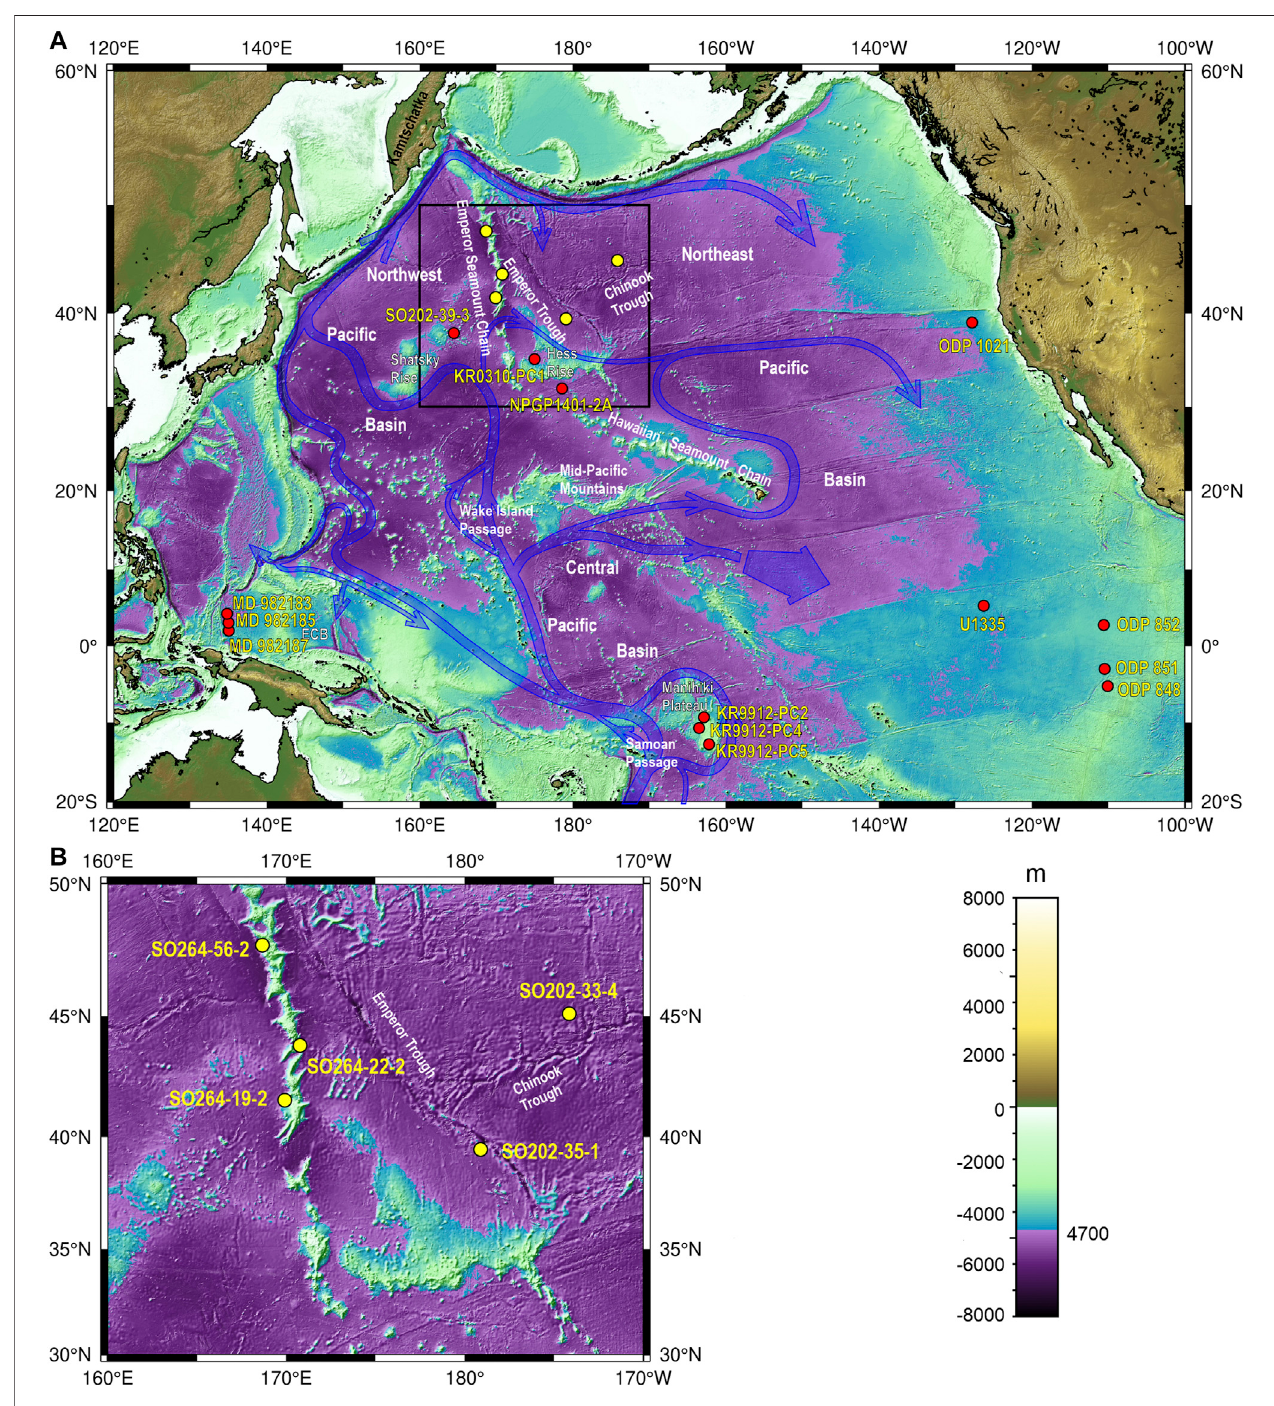
FIGURE 1| (A) Bathymetric and geographical setting of the North and Equatorial Paci fi cOcean. The bathymetry data isfrom the General Bathymetric Chart of the Ocean(GEBCO,2020).Thecolorscaleindicateswaterdepth(m).Asharpchangefrombluetopurpleinthecolorscalemarksthewaterdepthof4,700 mcorresponding totheNorthPaci fi cCCDboundary(Lyle,2003).DeepwatercurrentsweredrawnaccordingtoKawabeandFujio(2010).Yellowcirclesrefertothecoresofthisstudy,red circles to previously published RPI records; a black rectangle encompasses the study area. ECB: East Caroline Basin, WCB: West Caroline Basin. (B) Close-up section of study area with the fi ve sediment cores of RV SONNE Expeditions 202 and 264 presented here.